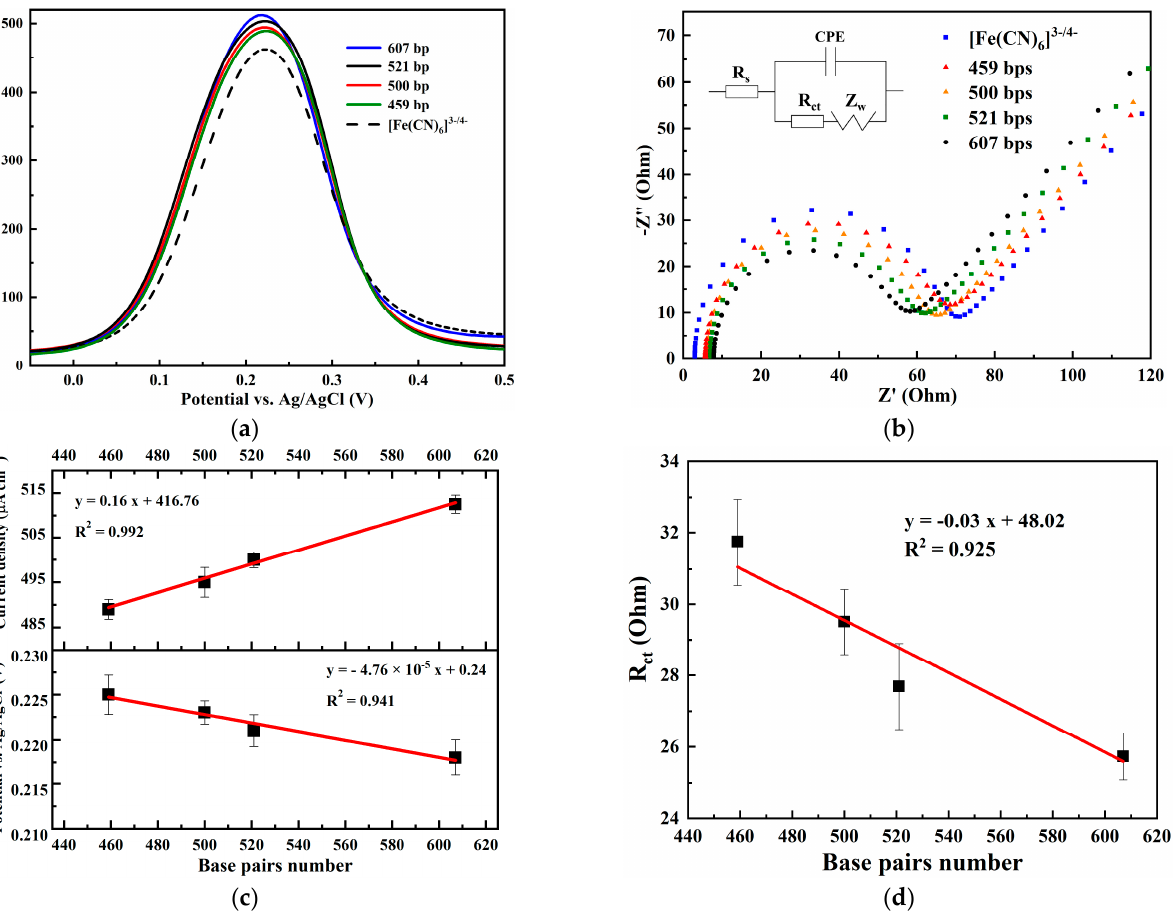
Figure 5. Electrochemical responses of [Fe(CN) 6 ] 3 − /4 − probe capturing at di ff erent bps nucleotides in 0.1 M KCl phosphate bu ff er solution (pH = 7.4) using ( a ) DPV and ( b ) EIS spectra presented as Nyquist plots in the frequency range from 0.1 Hz to 100 kHz at +0.2 V. The inset is the Randles equivalent circuit model used for EIS analysis, where R s is the electrolyte resistance, R ct is the charge transfer resistance, CPE is the constant phase element, and Z W is the Warburg di ff usion element. ( c ) Calibration of current density, potential, and ( d ) R ct vs. DNA base pairs number.